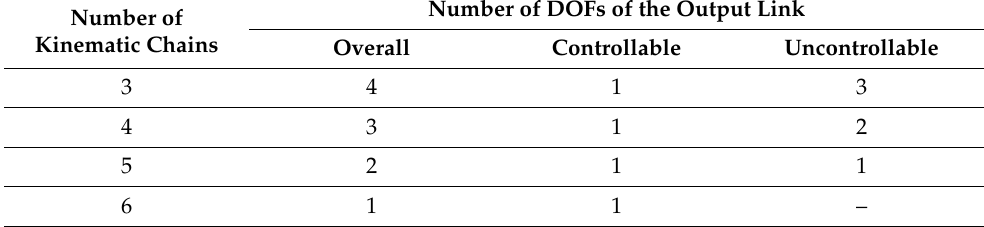
Table 1. Summary of the mobility analysis results. Number of DOFs of the Output Link Number of Kinematic Chains Overall